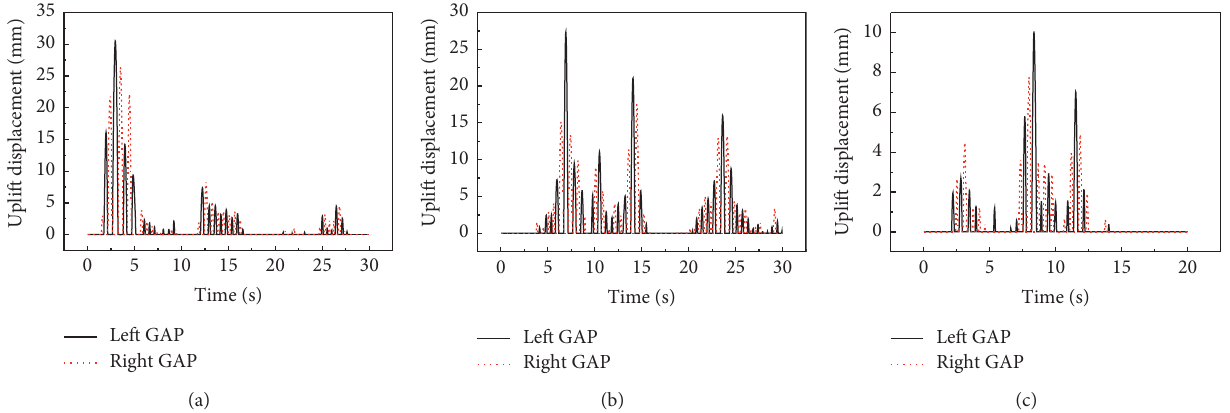
Figure 23: Time-history curves of GAP’s uplift displacement under extremely rare earthquake: (a) El Centro wave; (b) Taft wave; (c) artificial